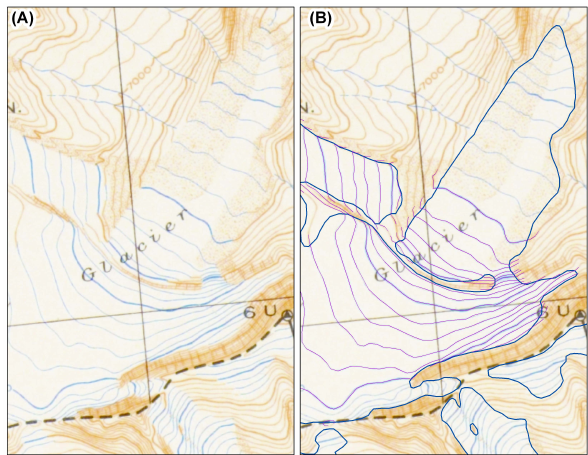
Fig. 3. Example of (A) a glacier on the IBCS maps and (B) its digi- tized extents and